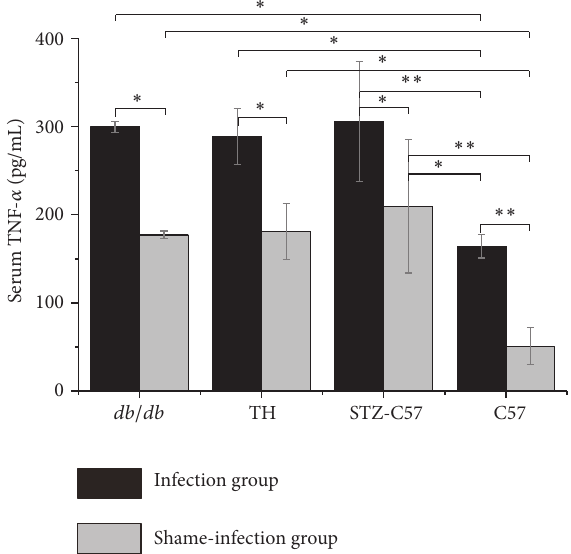
Figure 4: Serum TNF- 𝛼 level at time of sacrifice determined by ELISA ( ∗ 𝑃 < 0.05 ; ∗∗ 𝑃 < 0.01 ).